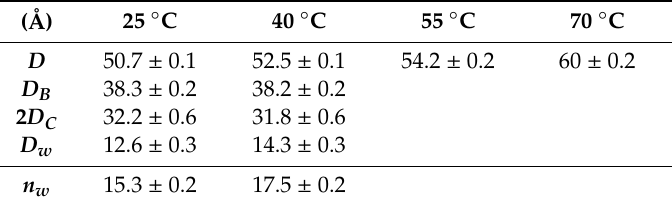
Table 2. Structural parameters from DoPhPC:DoPhPE (9:1) fully hydrated with 8% D 2 O obtained by neutron diffraction as a function of temperature. In case of 55 °C and 70 °C, it was not possible to extract all parameters as the membranes were not sufficiently structured to yield enough Bragg peaks.